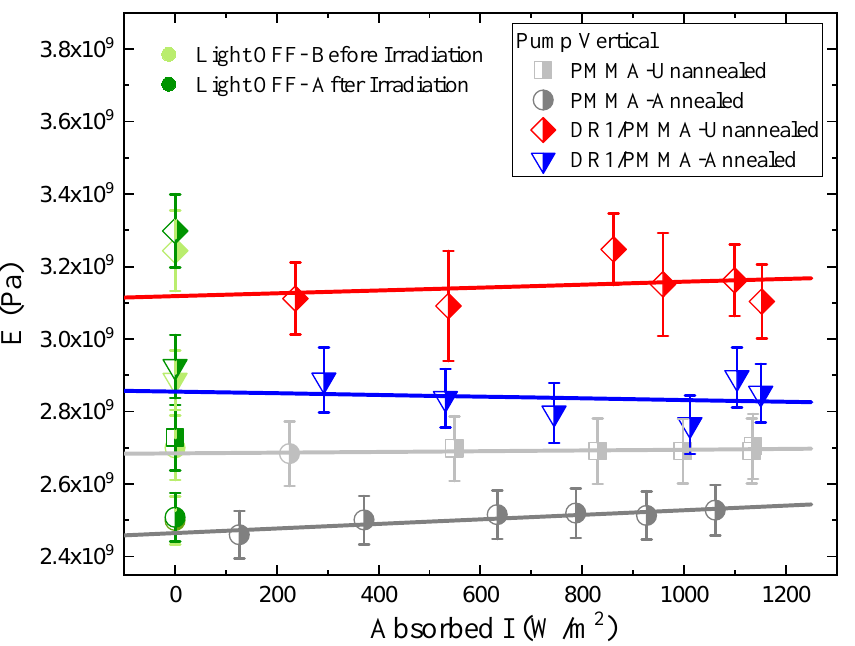
Figure 12. Young’s Modulus of unannealed and annealed PMMA and DR1/PMMA fibers as a function of vertically polarized absorbed pump intensity. The lines are fits to the non-zero-intensity data